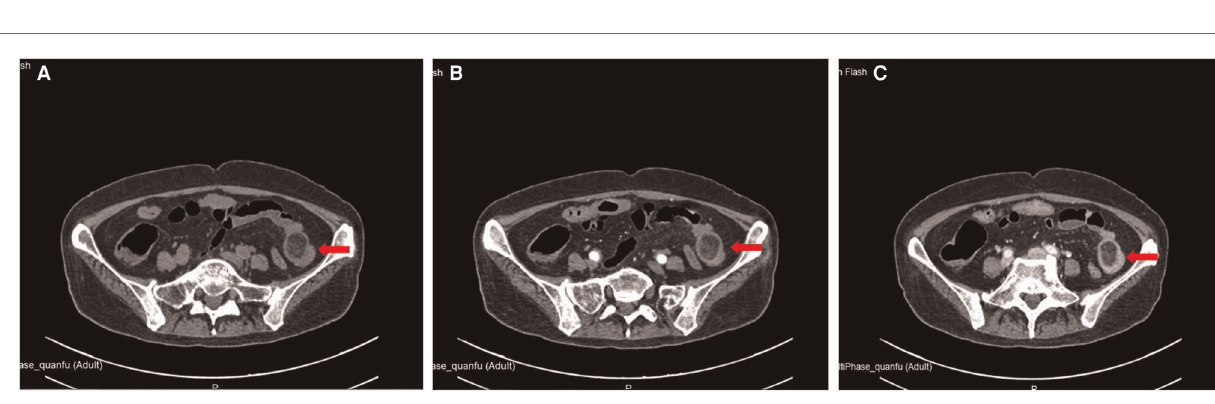
FIGURE 2 | Location of small intestinal tumor in abdominal enhanced CT. ( A ) plain scan; ( B ) arterial phase; ( C ) venous